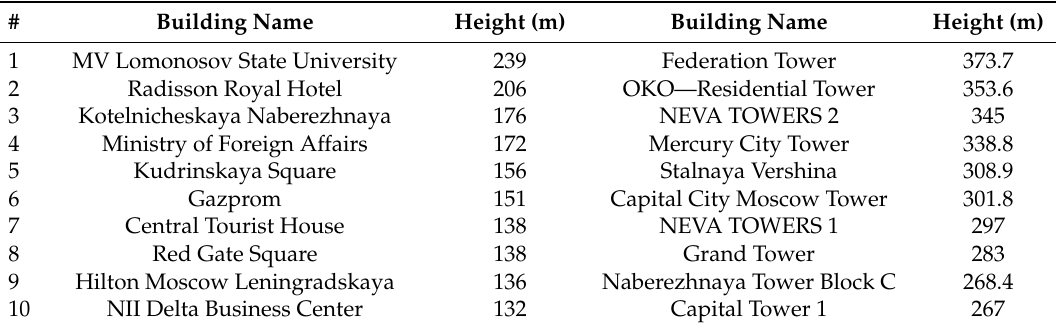
Figure 8. Moscow in 2000 and 2020. Table 18. Moscow’s 10 tallest skyscrapers in 2000 and 2020.